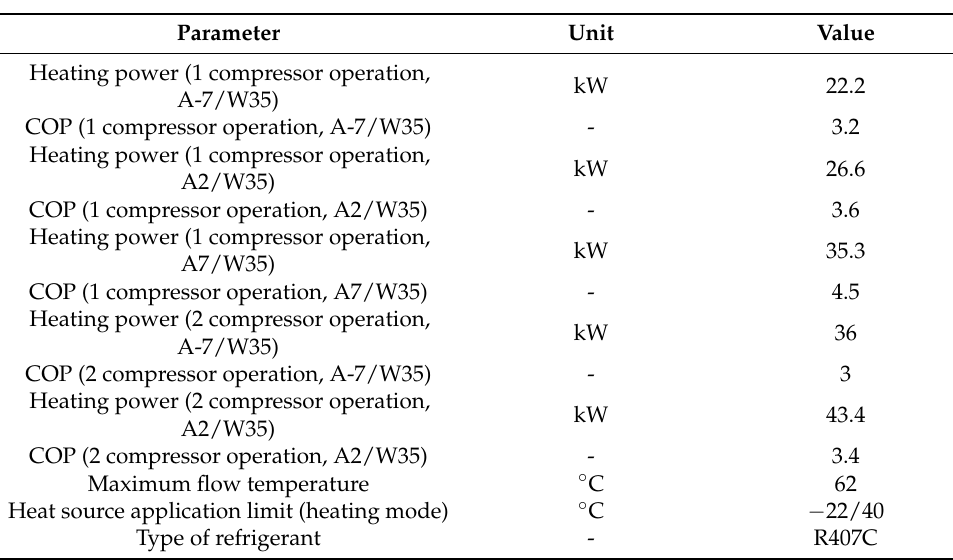
Table 2. Technical data heat pump LA 60S-TU, manufactured by the Dimplex